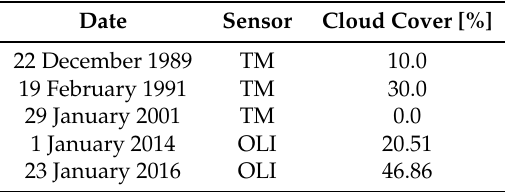
Table 1. Available Landsat